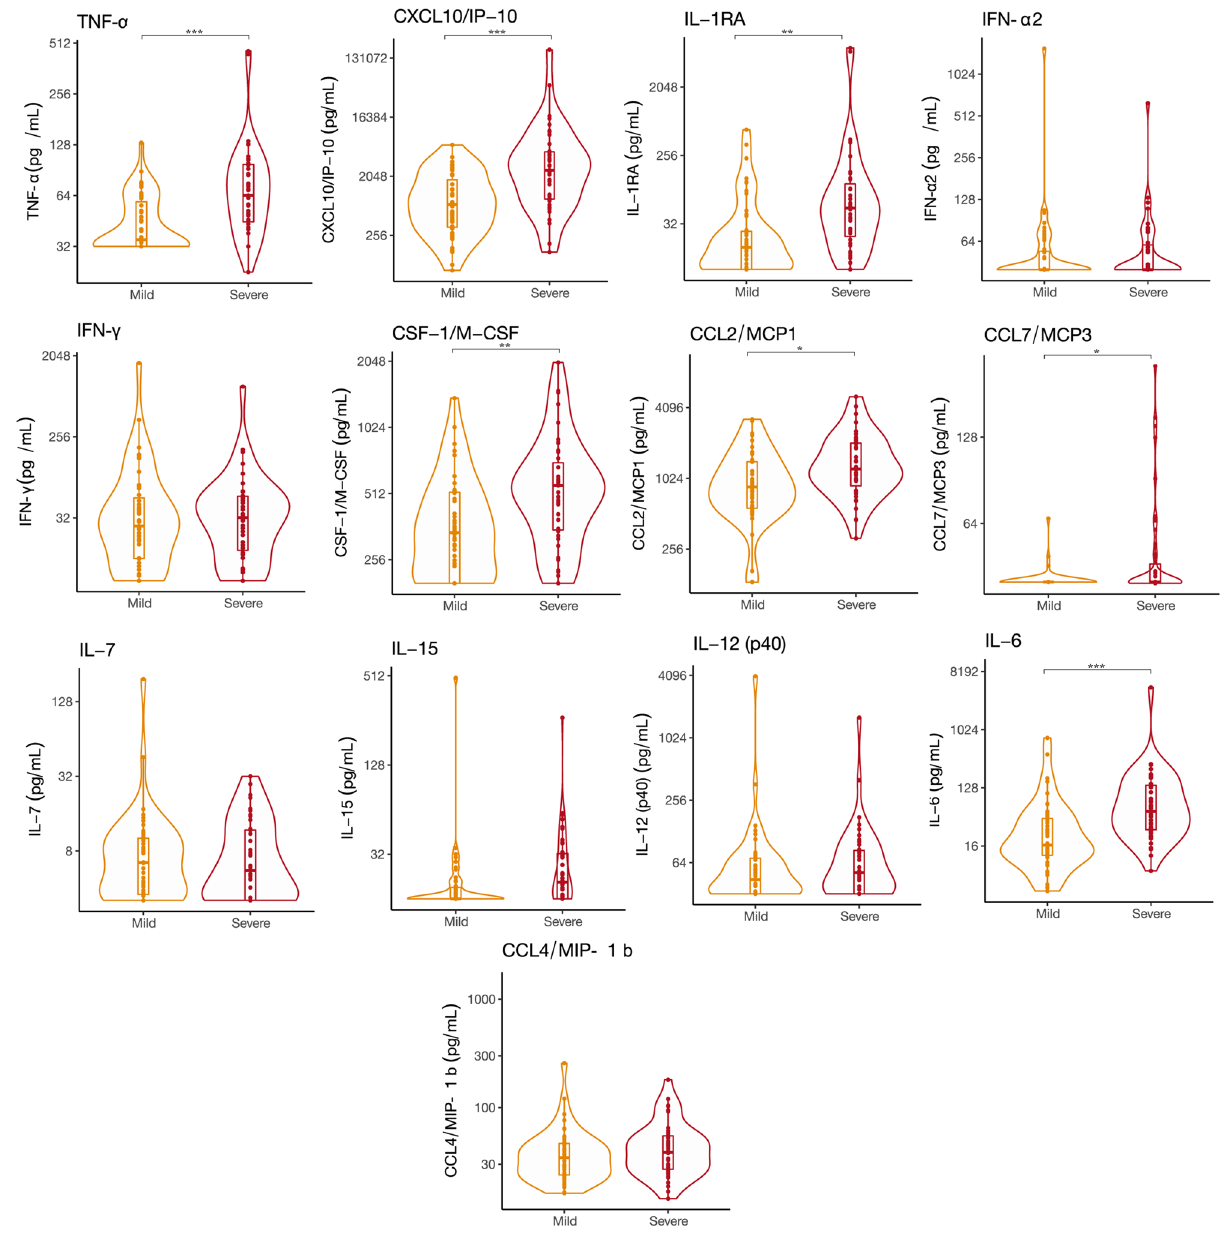
Figure 2. Cytokine expression of inflammatory cytokines in mild and severe COVID19 patients. The curved line of the violin box plots show the density of day 1 of hospital admission the cytokine expression levels. The horizontal line in the inner box plot represents the median and interquartile range. Each dot represents a subject (COVID-19, Mild = 56; Severe, n = 34). Significance of comparisons were determined by an unadjusted linear regression models using log-scaled cytokines and robust standard errors. p-values after adjustment for multiple comparisons accompany the respective comparisons. *p < 0.05, **p < 0.01, ***p <